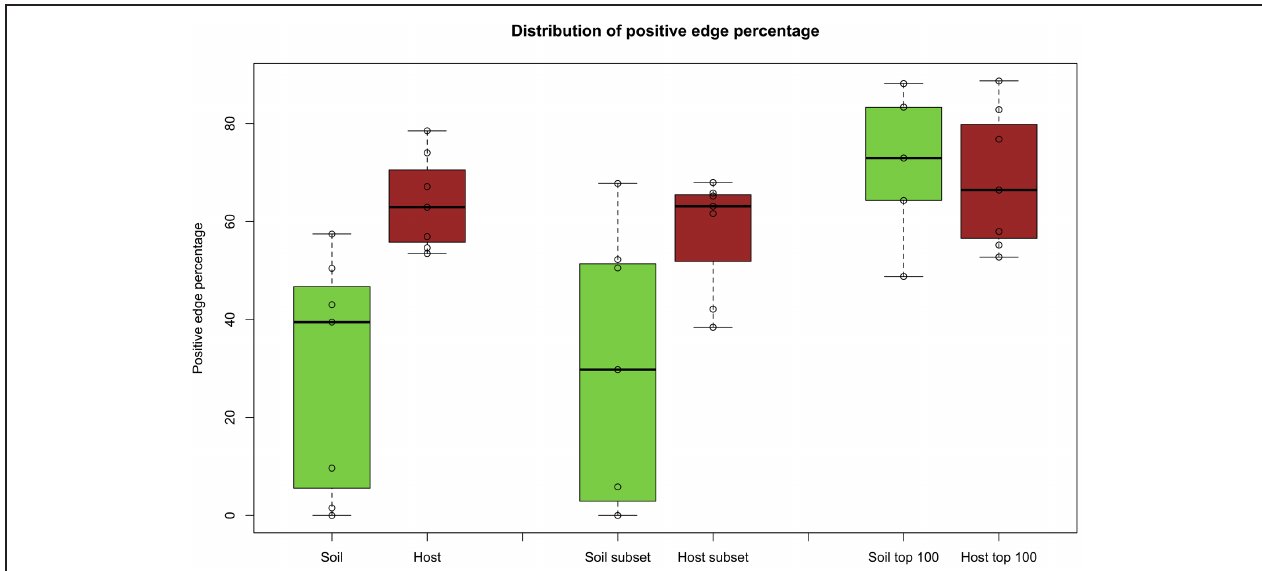
FIGURE 7 | PEP for top 100 prevalent taxa. When networks are inferred from the top 100 prevalent taxa, the average PEP of soil networks increases, in contrast to host networks (fifth and sixth box plot). For comparison, PEP distributions of soil and host networks (first and second box plot) as well as soil and host networks excluding biomes with less than 100 OTUs (nasal cavity, skin, and vagina from the HMP dataset) and without higher-level taxa and metadata (third and fourth box plot) are also displayed. The Wilcoxon rank sum test for the latter case (third and fourth box plot) gives a p -value of 0.0014, whereas the PEP distribution difference for top-prevalent soil and host OTUs is no longer significant ( p -value: